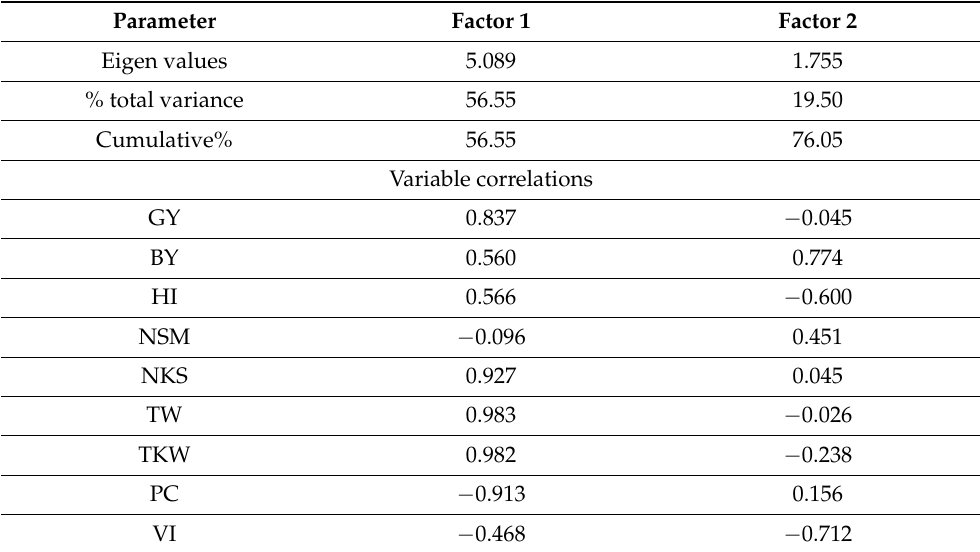
Table 6. Principal components analysis (PCA) based on yield, yield components, and quality